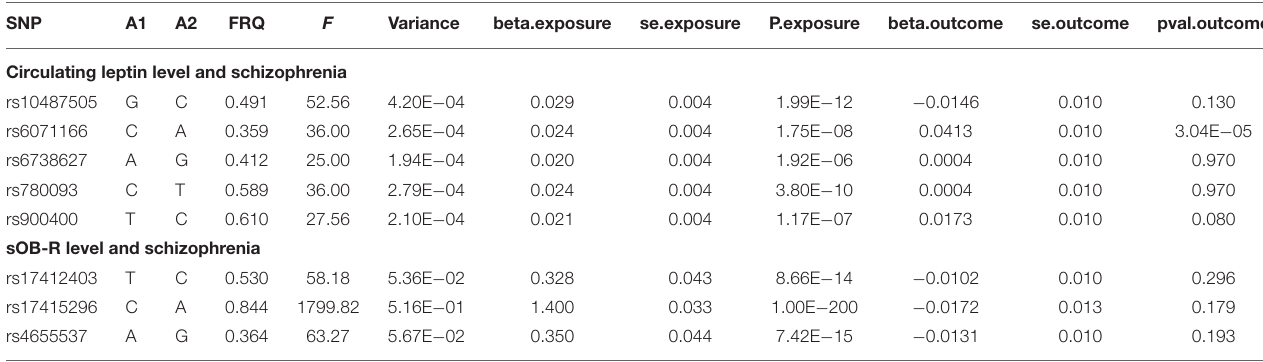
Variance beta.exposure se.exposure P.exposure beta.outcome se.outcome